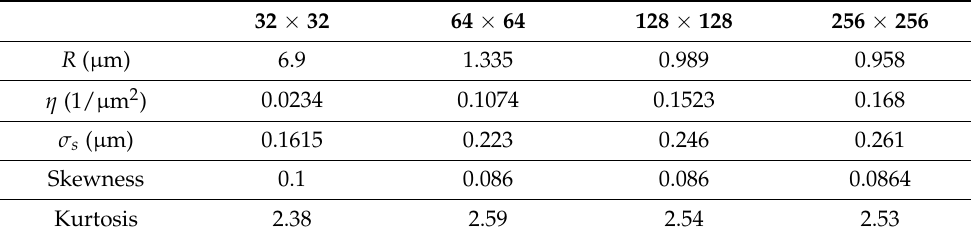
Table 1. Statistical parameters for surface 4L for difference node